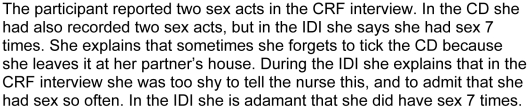
Desirability bias.